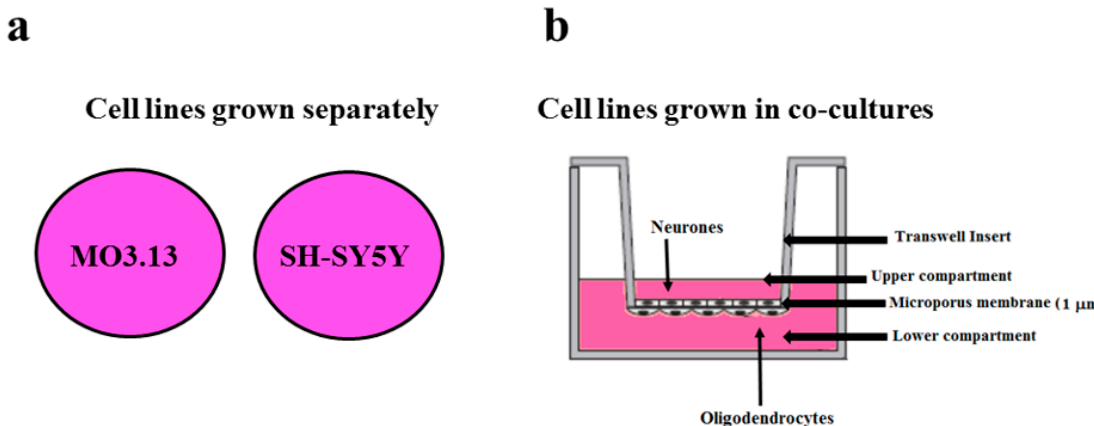
Figure 1. ( a ) Cell lines were grown separately ( b ) Differentiated oligodendrocytes and neurons were placed on the outer and the inner portion of Transwell insert respectively. The used Transwell insert may prevent the cell migration thanks to a polyester membrane with 1µm pores. Under these experimental conditions, only the growth medium was in contact with both the cell